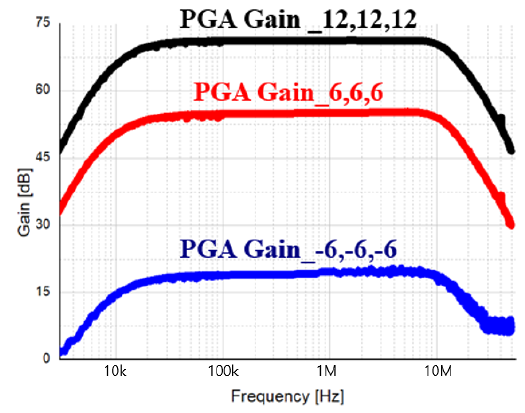
Figure 39. Measurement result of PGA gain of receiver.